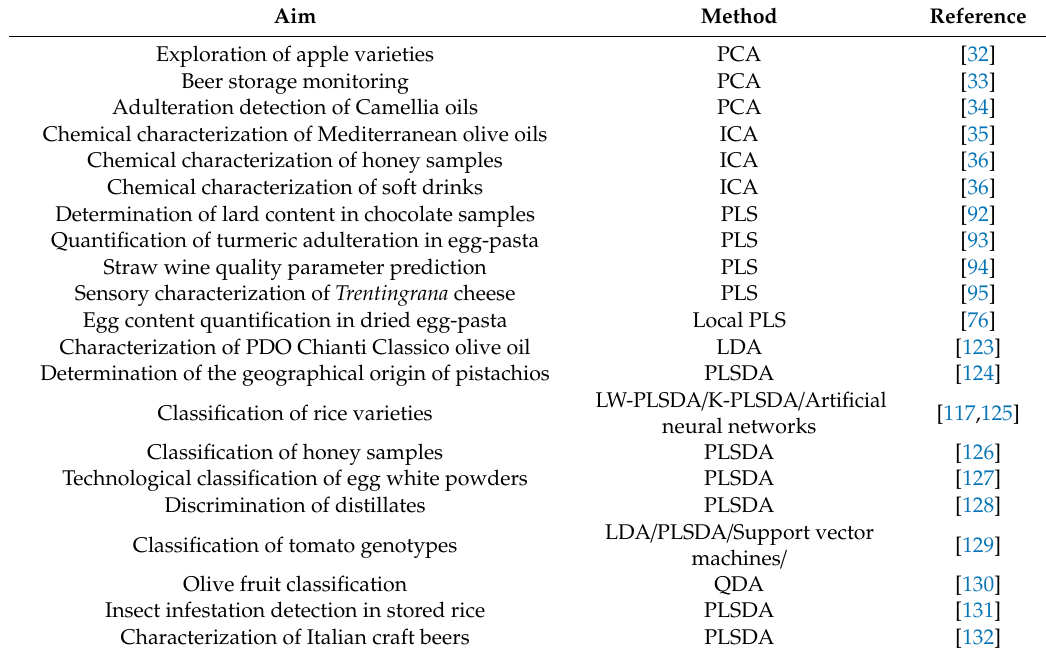
Table 1. Application examples of exploratory, regression and classification analysis of spectroscopic data in the field of food science. PDO, PCA, ICA, PLS, LDA, PLSDA, LW-PLSDA, K-PLSDA and QDA stand for Protected Designation of Origin, Principal Component Analysis, Independent Component Analysis, Partial Least Squares, Linear Discriminant Analysis, Partial Least Squares Discriminant Analysis, Locally Weighted Partial Least Squares Discriminant Analysis, Kernel-Partial Least Squares Discriminant Analysis and Quadratic Discriminant Analysis,